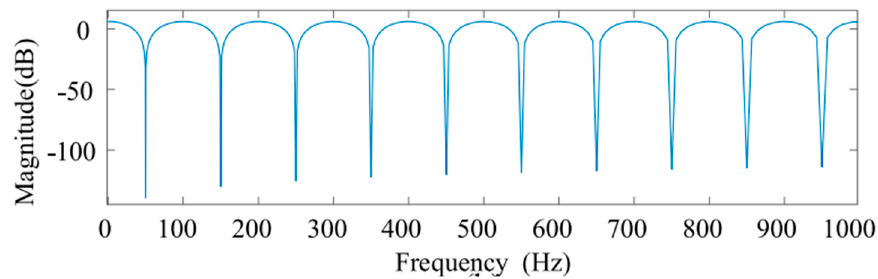
Figure 14. Bode diagram of a half-cycle SDFT.